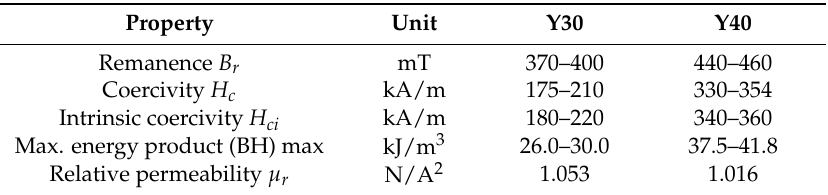
Table 1. Properties of the ferrite permanent magnets Y30 and Y40.